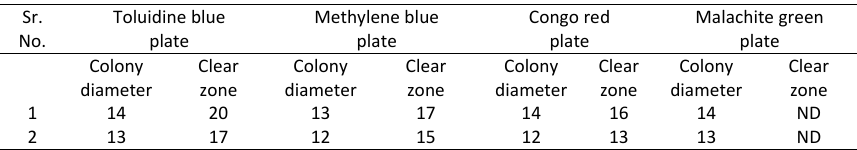
Table 2: Zone of clearance (mm) by PHP7 and PKD5 on different dye Table 2. Zone of clearance (mm) by PHP7 and PKD5 on different Sr. No.